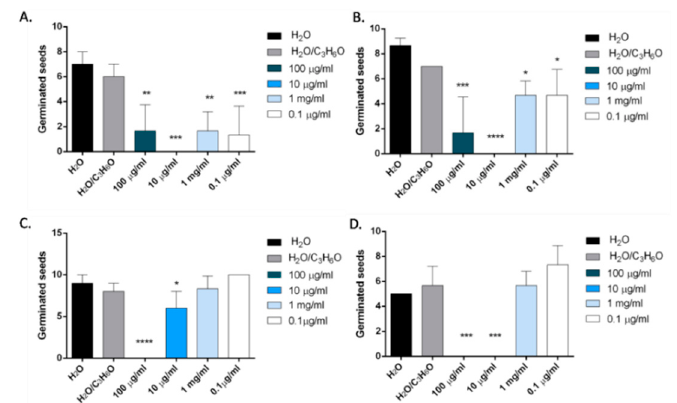
Figure 13. Phytotoxic activity of terpinen-4-ol against germination of S. lycopersicum ( A ), R. sativum ( B ), L. sativa ( C ), L. sativum L. ( D ). Results are expressed as the mean of three experiments standard deviation. * p < 0.05, ** p < 0.01, *** p < 0.001, **** p < 0.0001 compared to control (ANOVA followed by Dunnett’s multiple comparison test).